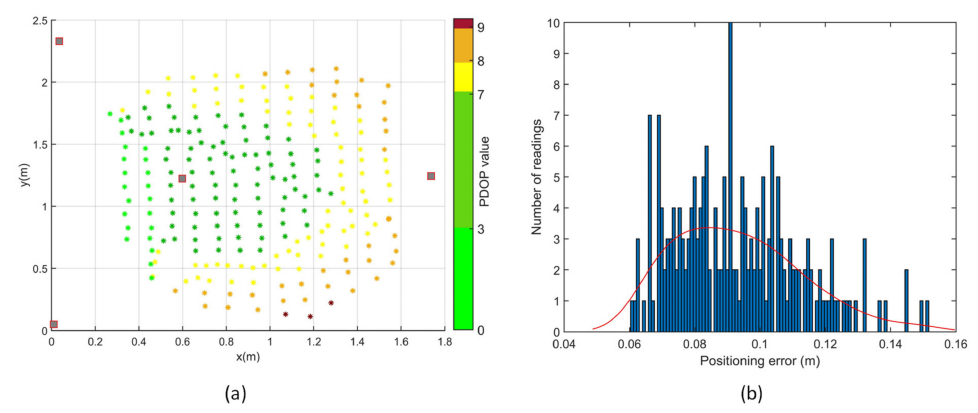
Figure 13. Positioning tests with transmitters arranged in trigonal planar arrangement. Table 6. Positioning test results.